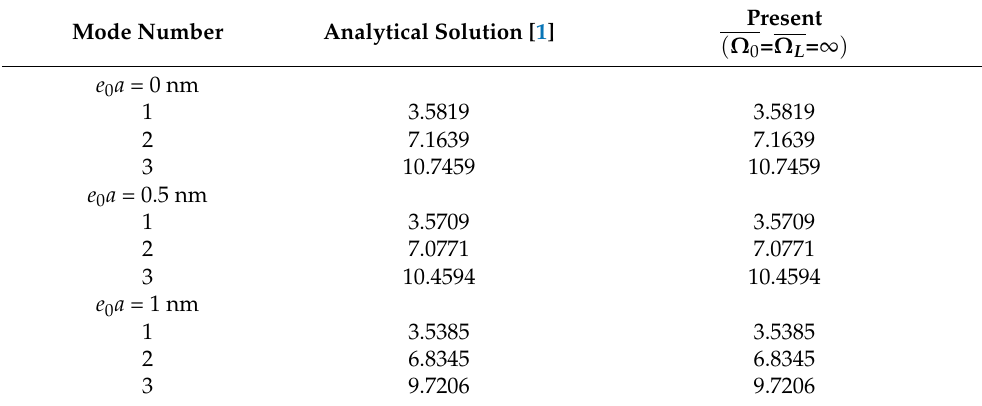
Table 1. Comparison of the first three non-dimensional axial frequencies of randomly oriented short-fiber-reinforced composite nano-rods for the clamped–clamped boundary condition.